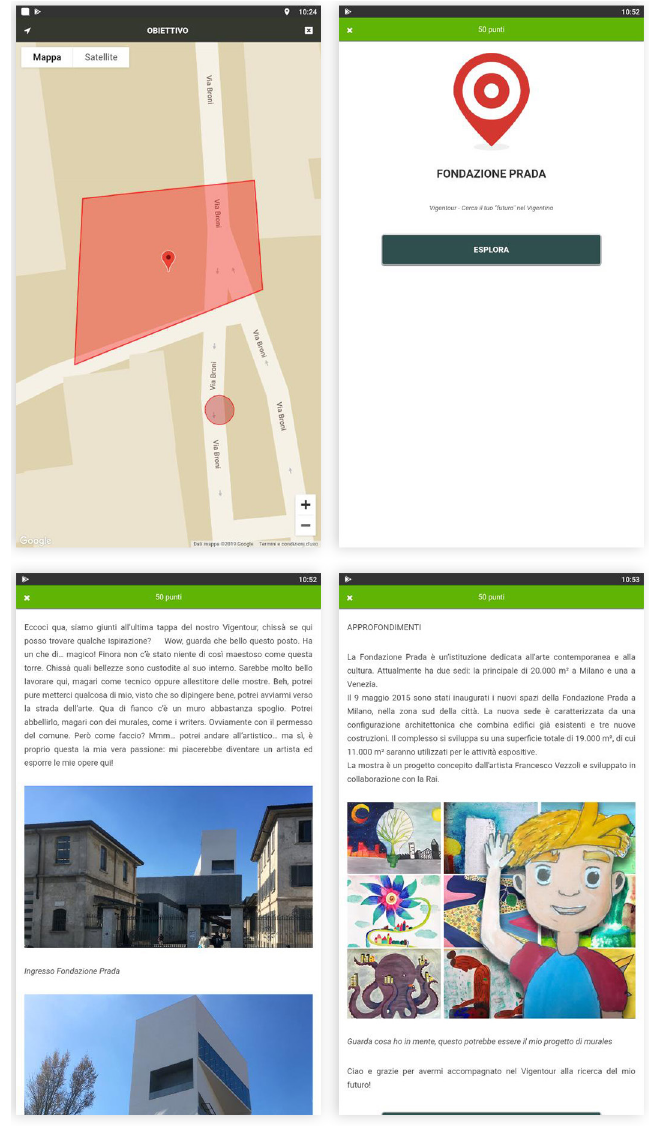
Fig. 1 Screenshots from the serious game developed by middle school